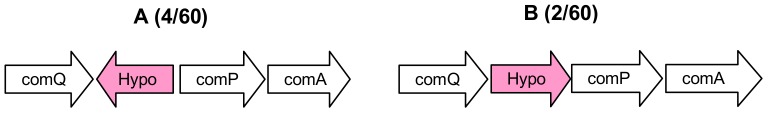
Unusual comQXPA-like loci.(A) Non-canonical unusual com system is present in B. cereus VD102, B. cereus BAG4X12 1, B. cereus MSX A1 and L. fusiformis ZC1. Note that Lysinibacillus is the only genus whose two species have two com loci each: L. sphaericus C3 41 has two canonical loci while in L. fusiformis ZC1 one locus is canonical and the other one is non-canonical, shown here. (B) Canonical unusual com system present in Paenibacillus curdlanolyticus YK9 and B. coagulans 36D1.